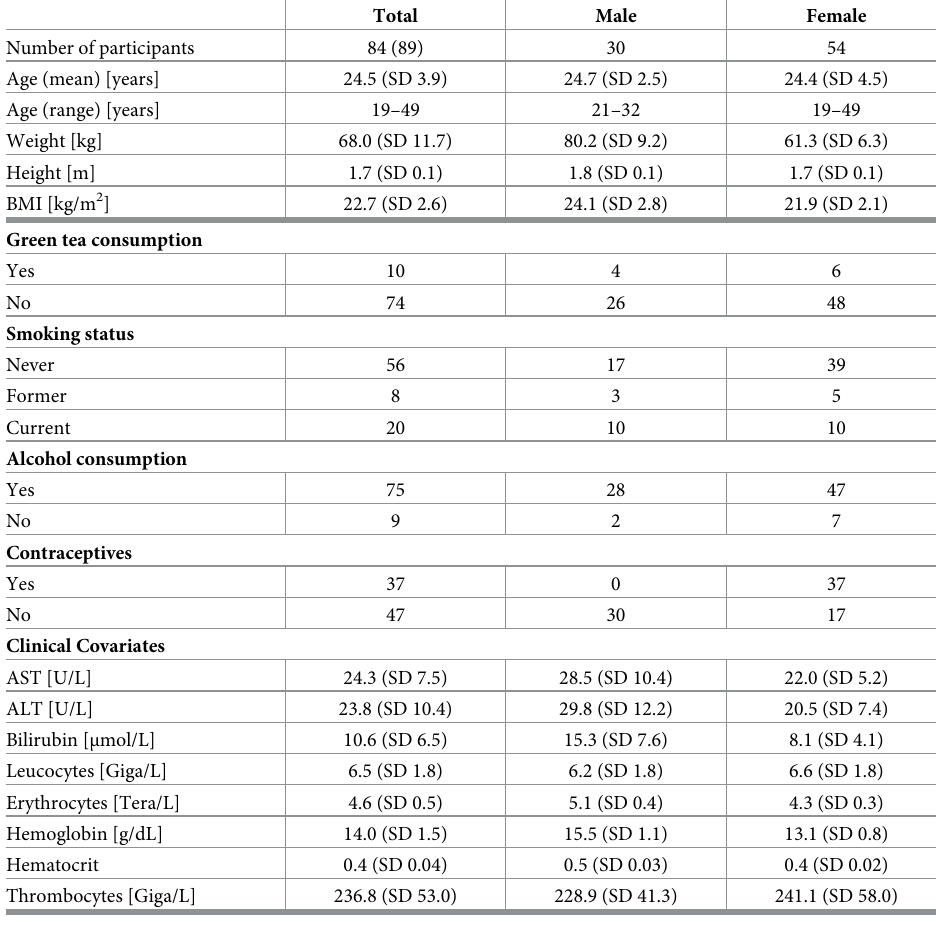
Table 1. General characteristics of the study